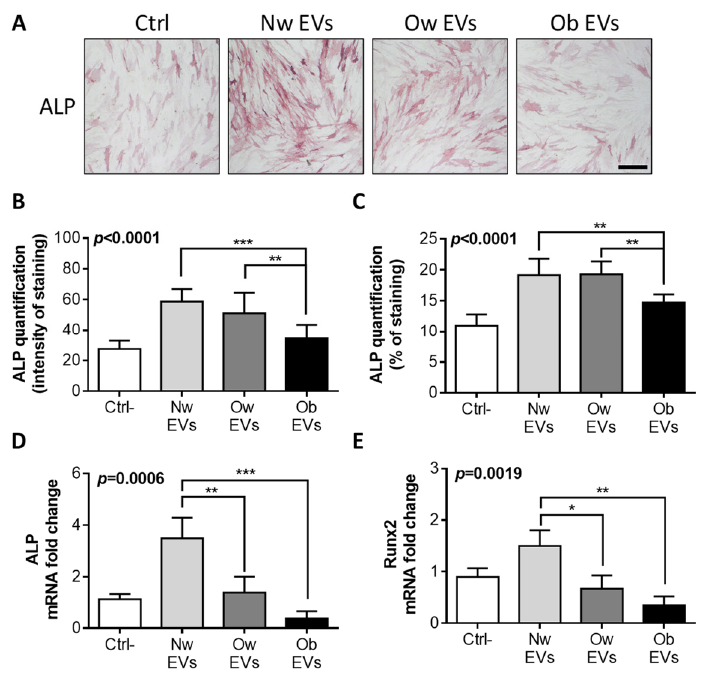
Figure 5. ( A ) Human primary mature osteoblasts were treated for 3 days with EVs collected from children with normal weight (NW EVs), overweight (Ow EVs) and obesity (Ob EVs), and compared to the control condition (Ctrl-) with no EV treatment. At the end of the experiment, mature osteoblasts were stained for ALP to assess any modulation in the osteogenic differentiation. Scale bar: 200 µ m. Quantification of the ALP intensity of staining ( B ) and percentage of staining ( C ) in osteoblasts treated with EVs for 3 days. RT-PCR for the expression of osteoblastic differentiation marker ALP ( D ) and the differentiation master-gene Runx-2 ( E ) in osteoblasts treated with NW, Ow and Ob EVs for 3 days, normalized versus the housekeeping GAPDH. * p < 0.05; ** p < 0.01; *** p < 0.001.